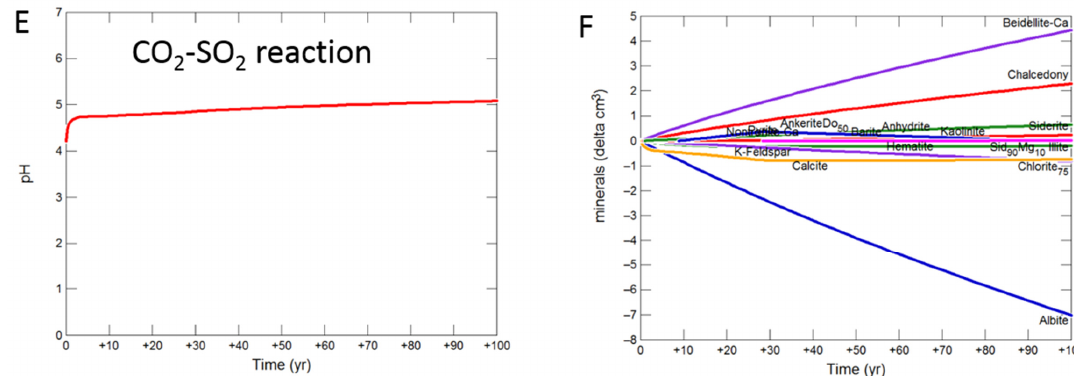
Figure 11. Up ‐ scaled shale cap ‐ rock reaction over 100 years. Reaction with CO 2 ‐ SO 2 ‐ O 2 ( A ) predicted pH; ( B ) predicted change in mineral volumes (delta cm 3 ), where positive values indicate precipitation, and negative values dissolution; Reaction with CO 2 ( C ) predicted pH; ( D ) predicted change in mineral volumes; Reaction with CO 2 ‐ SO 2 ( E ) predicted pH; ( F ) predicted change in mineral volumes.